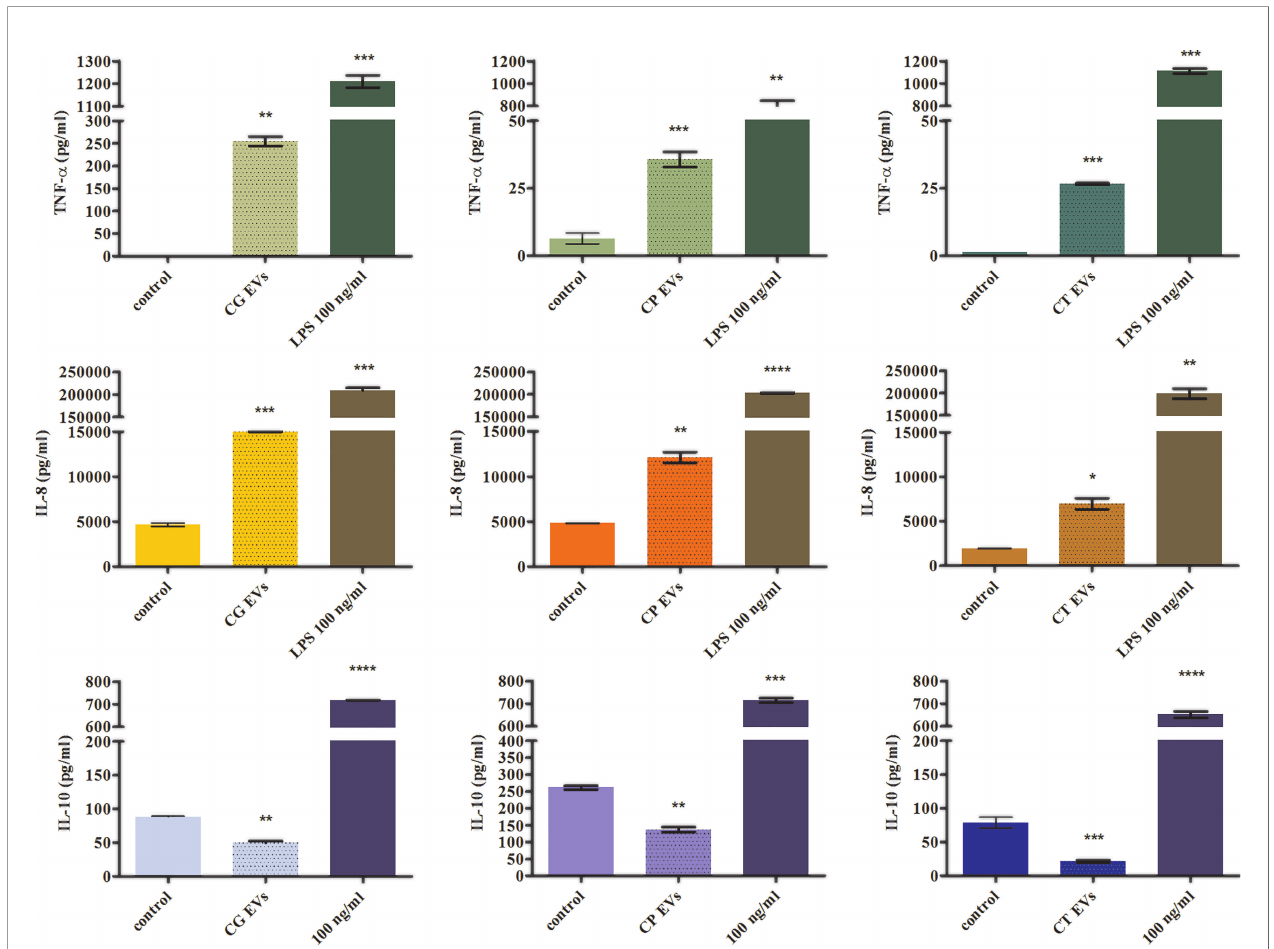
FIGURE 4 | The analysis of cytokine production by THP-1 cells stimulated with Candida EVs. The amount of a particular cytokine was shown for stimulation with C. glabrata EVs (CG), C. parapsilosis EVs (CP), and C. tropicalis EVs (CT). A representative result of three independent experiments is presented. To analyze the statistical signi fi cance versus control, an unpaired t -test was performed with GraphPad Prism software version 7.0 (GraphPad Software, La Jolla, CA, USA). The statistical signi fi cance levels were marked with * for p < 0.05, ** for p < 0.01, *** for p < 0.001, and **** for p <